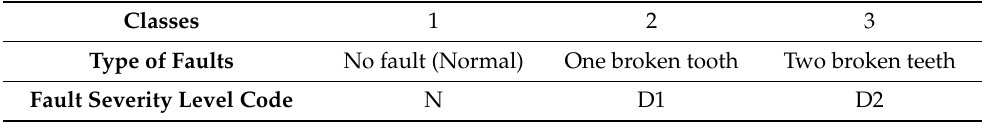
Table 1. Spiral bevel gears’ health